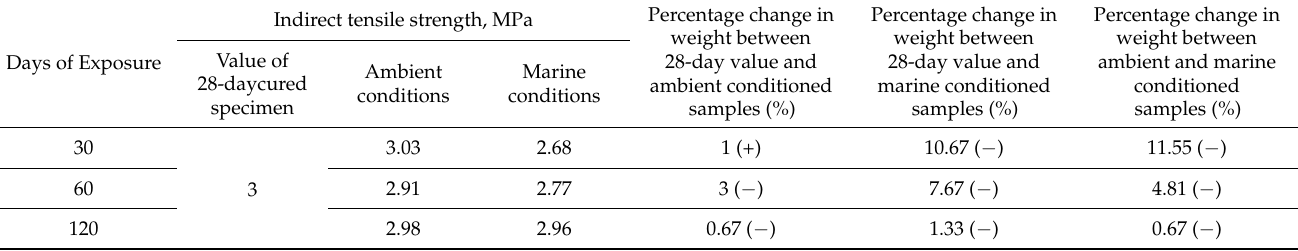
Table 7. Comparison of indirect tensile strength under ambient and marine exposure conditions.